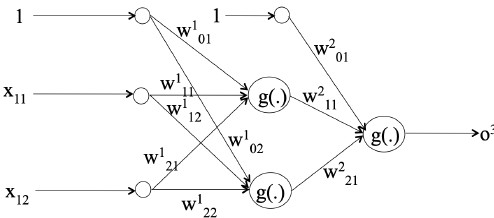
Figure 3. Example of an MLP, compounded by three different layers: An input layer, where the observations features are weighted, added and mapped by an activation function; A hidden layer, where the outputs of the input layer are weighted, added and mapped by an activation function; And output layer where the output of the hidden layer are weighted, added and mapped by an activation function in order to classify the